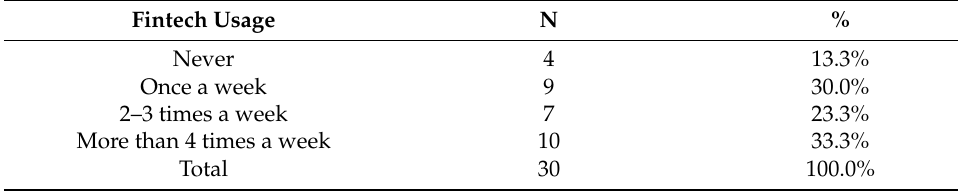
Table 7. Respondents’ Fintech usage frequency.